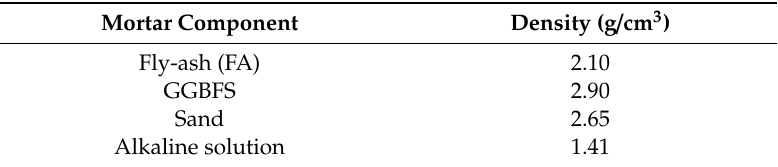
Table 5. Densities of mortar components.